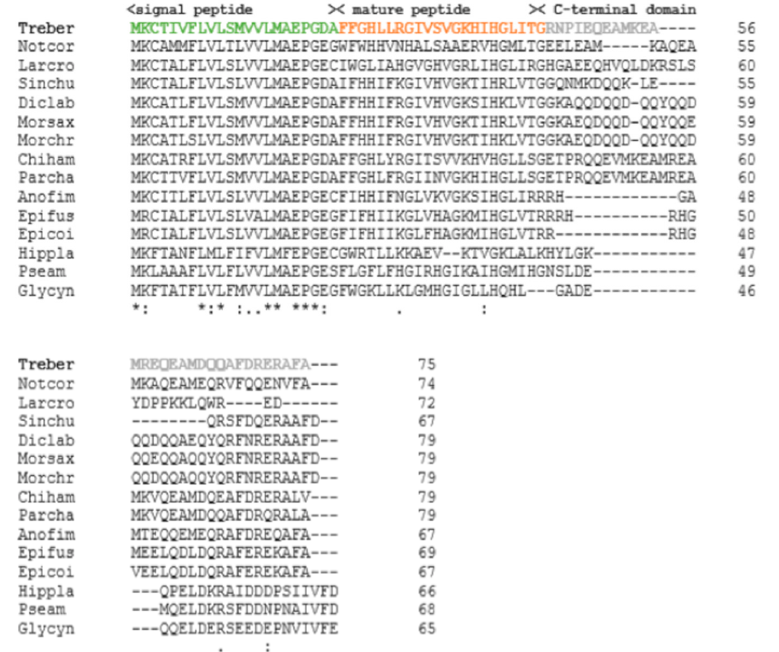
Figure 1. Multiple alignment of the predicted Trematocine amino acid sequence with other known AMP molecules from Teleost fish (accession numbers: Trematomus bernacchii , MH325166; Notothenia coriceps , XP_010772966; Larimichthys crocea , EU741827; Siniperca chuatsi , AAV65044; Dicentrarchus labrax, AAP58960; Morone saxatilis , AF385583; Morone chrysops , AAL57318; Chionodraco hamatus ,